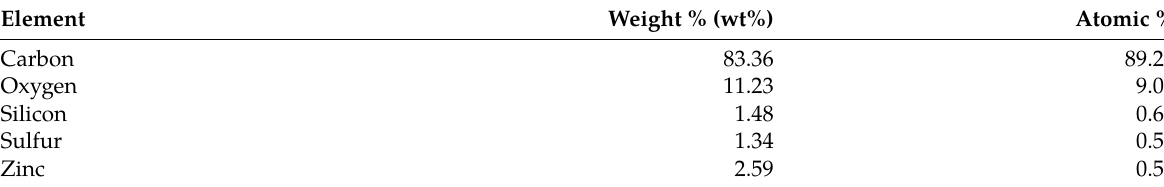
Table 4: Composition of the crumb rubber obtained by FE-SEM